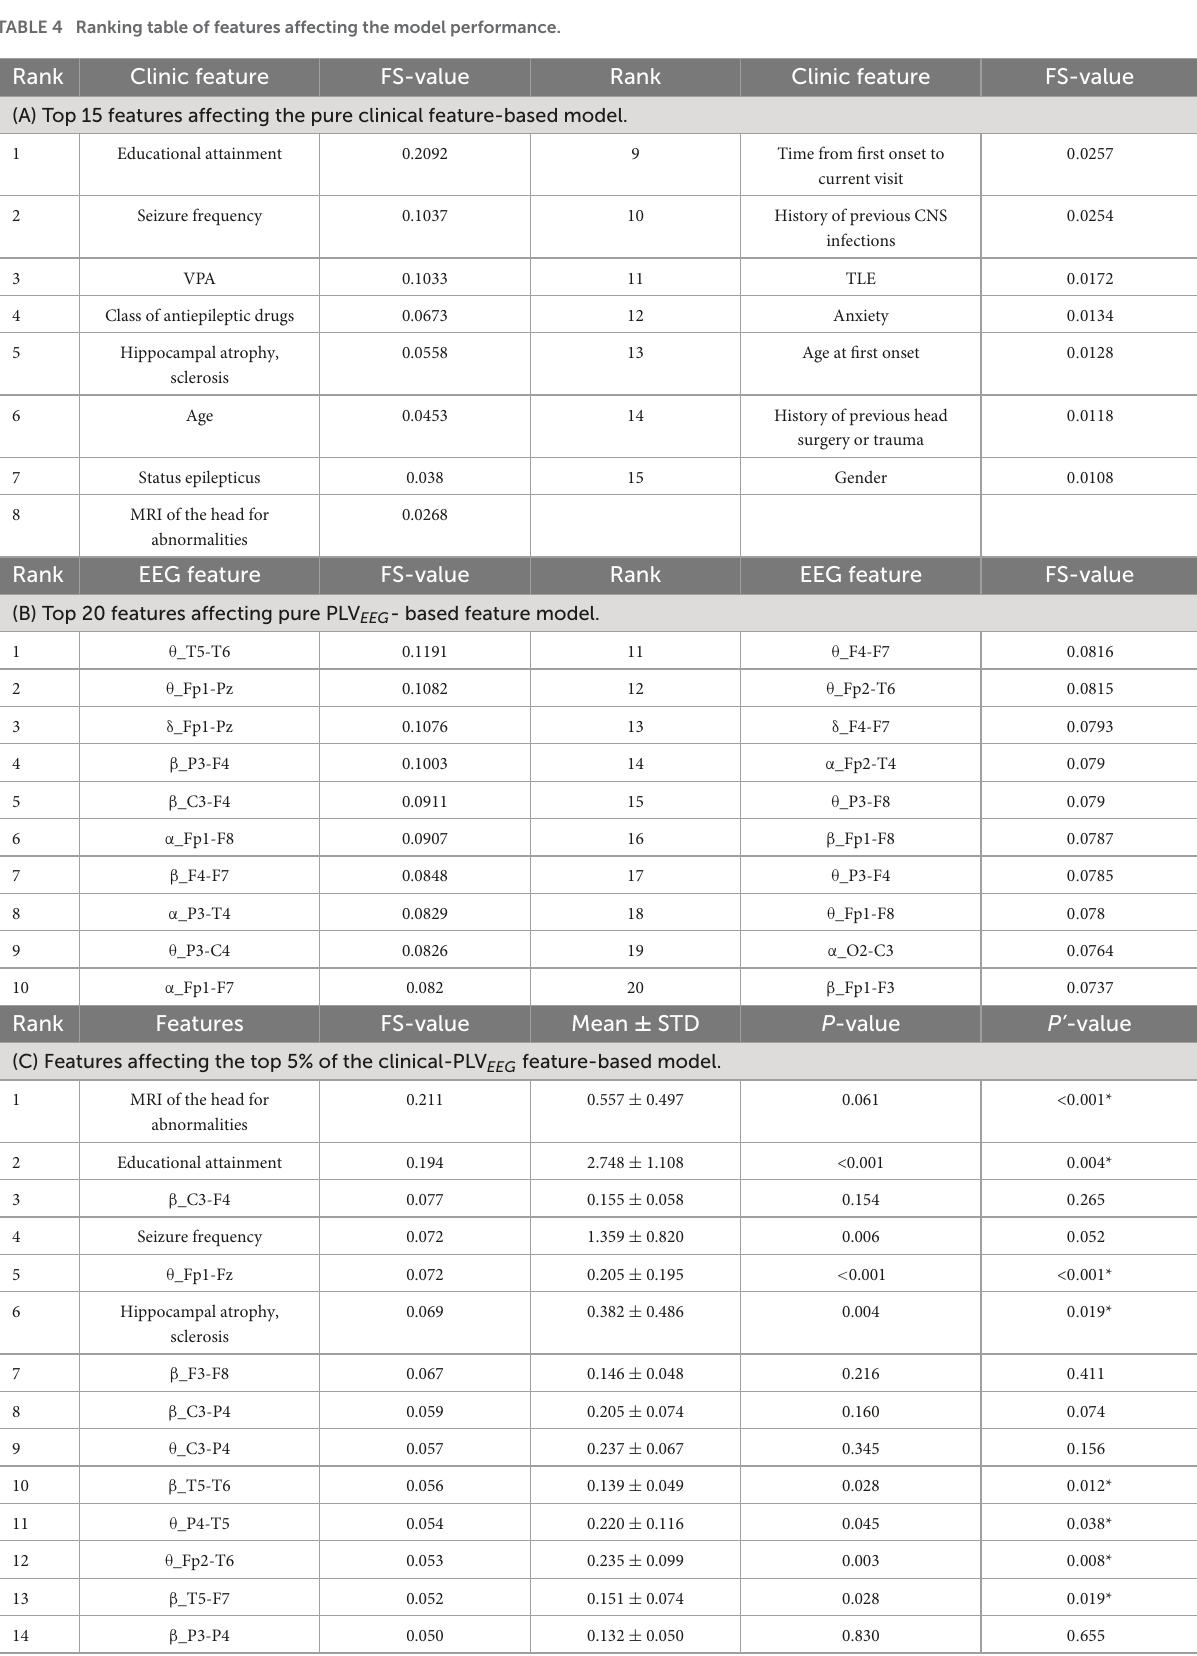
TABLE 4 Ranking table of features affecting the model